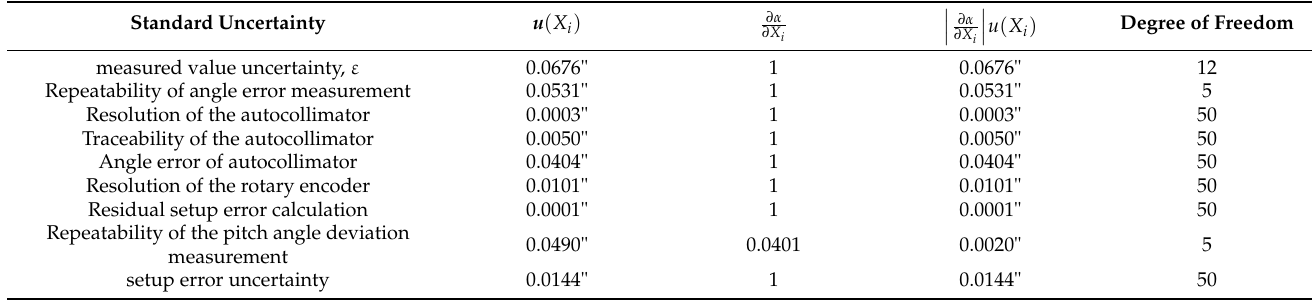
Table 3. Combined uncertainty for shift-angle